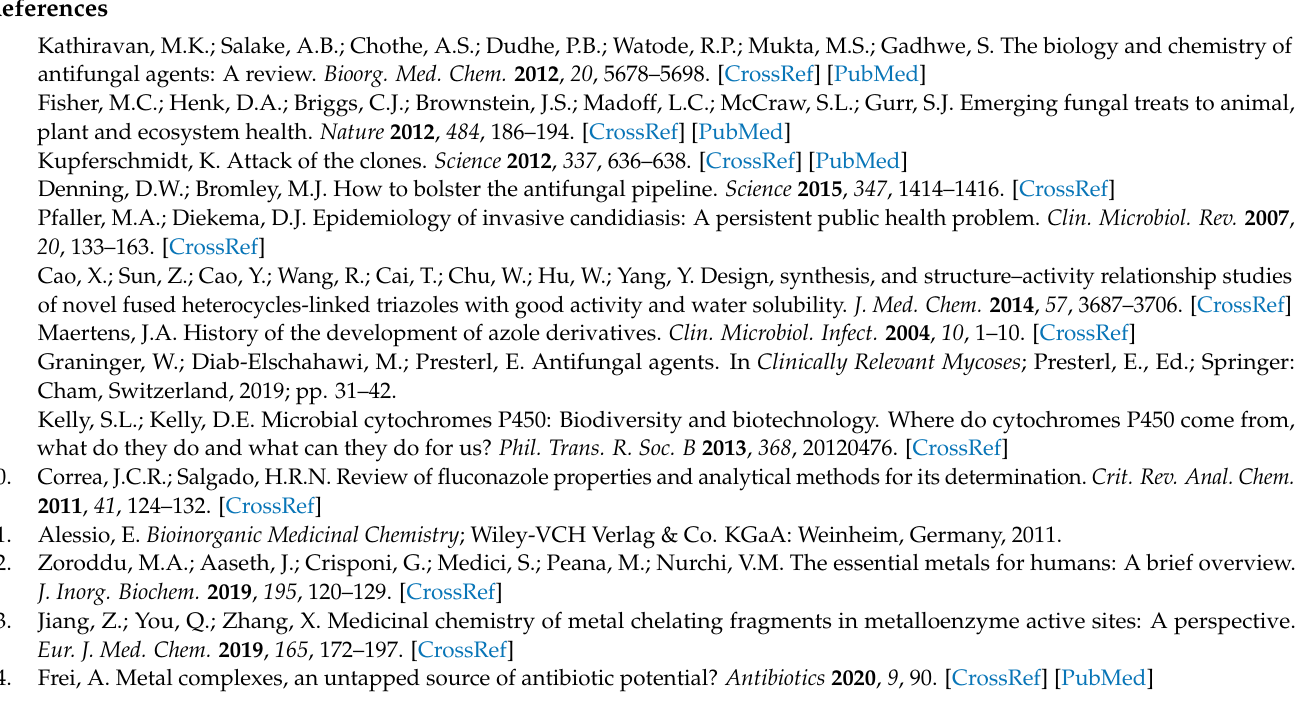
dark and light green, respectively, Figure S2: Hydrogen bond network in the structure of complex 1 . Hydrogen bonds are marked in blue. The hydrogen bond network acts as an additional bridging entity in the three-dimensional polymeric structure cross-linking parallel chains further adding to lattice stability, Figure S3: Hydrogen bond network in the structure of complex 2 . Hydrogen bonds are marked in blue. The hydrogen bonds provide additional weak stabilization of the crystal lattice, Figure S4: ( a ) Stability of complex 1 over time followed by UV-Vis spectrophotometry at 25 ◦ C in DMSO; ( b ) Stability of complex 2 in DMSO- d 6 /D 2 O ( v / v 3:1) solution over a period of 48 h followed by 1 H NMR spectroscopy, Table S1: Selected bond distances (Å) and valence angles ( ◦ ) in complexes 1 and 2 , Table S2: Details of the crystal structure determination for complexes 1 and 2 , Table S3: Effect of complex 2 and fluconazole on P. aeruginosa quorum sensing signaling pathway. The tested concentration was 50 µ